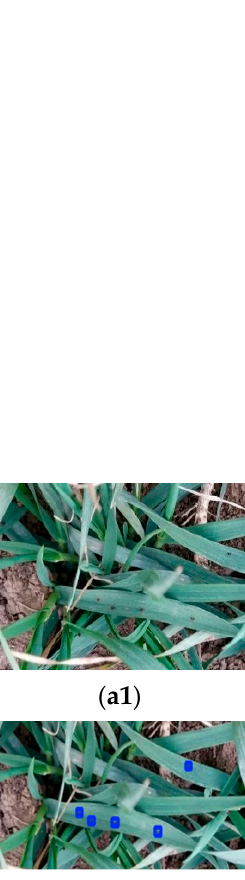
Figure 7. Rice sheath blight. ( a1 ), ( b1 ), ( c1 ), and ( d1 ) are the original images; ( a2 ), ( b2 ), ( c2 ), and ( d2 ) are the recognition results.